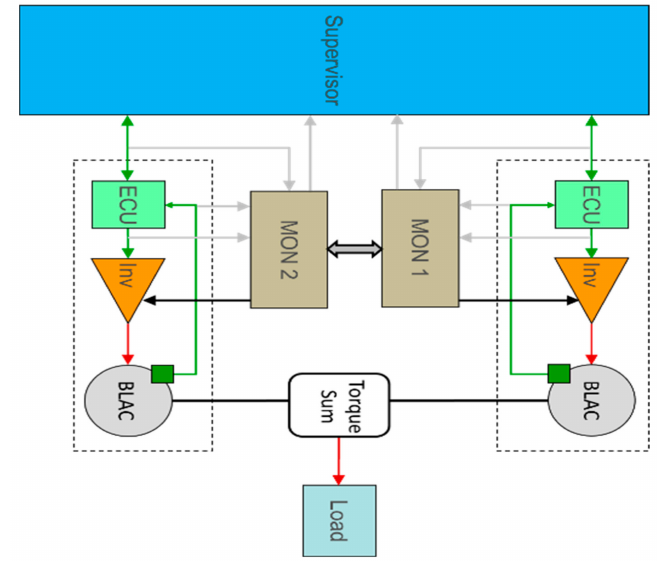
Figure 11. Architecture of the monitoring mode of one